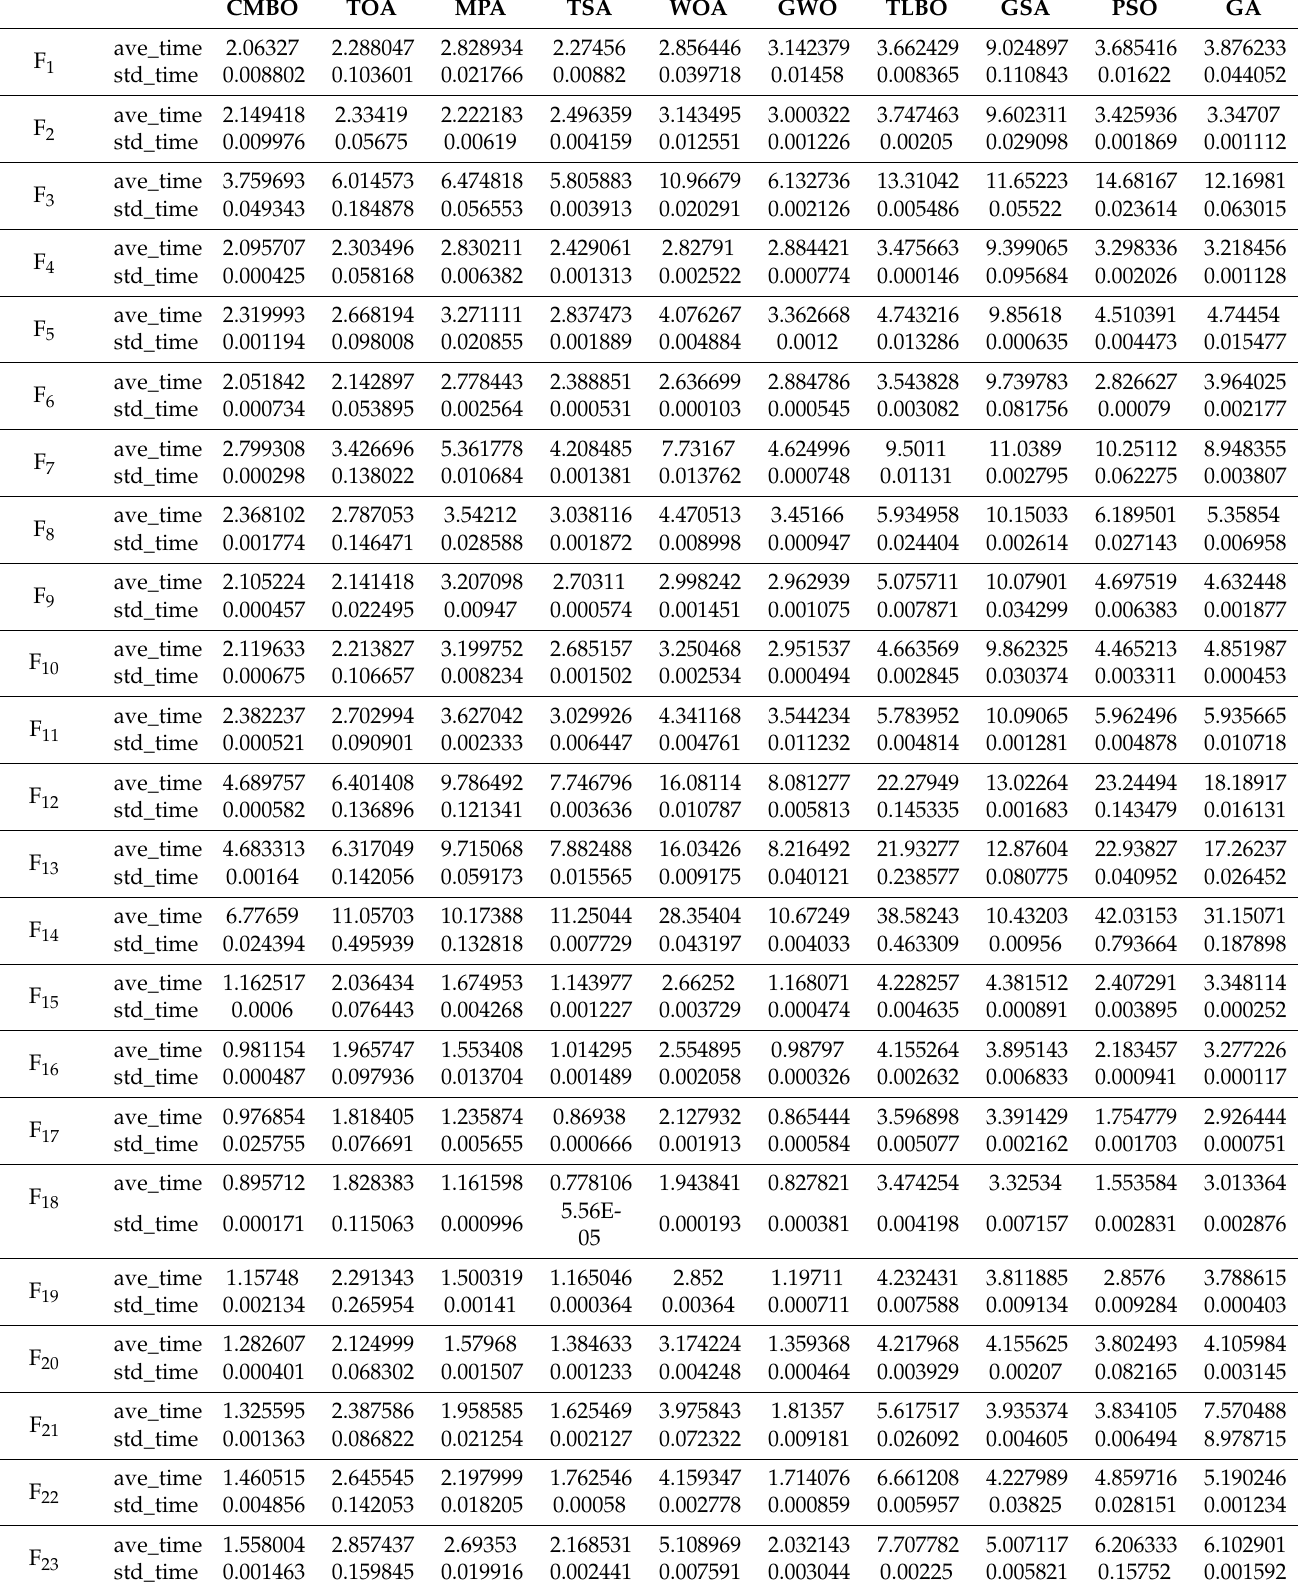
Table 10. Comparison of average execution time (ave_time) in seconds and the standard deviation for execution time